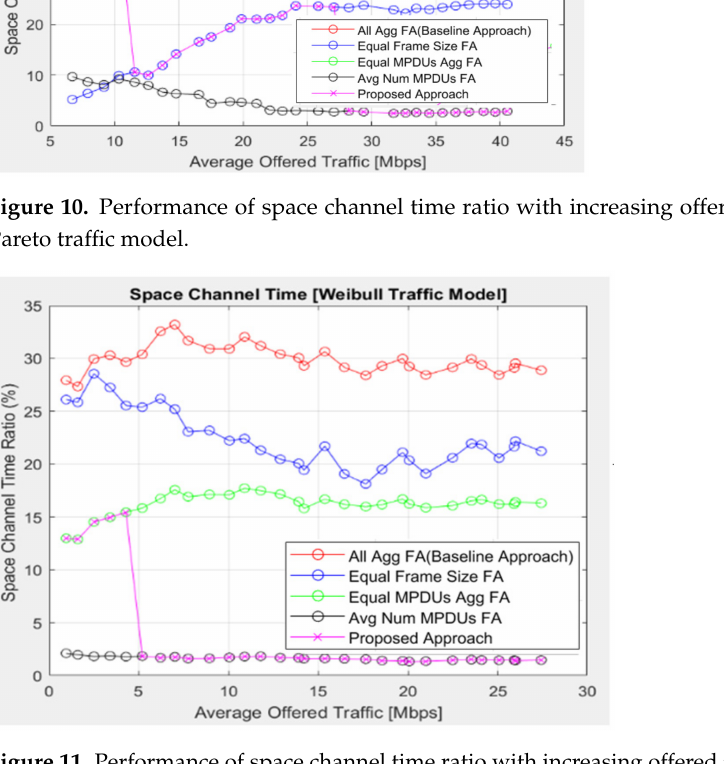
Figure 11. Performance of space channel time ratio with increasing offered traffic load using Weibull traffic